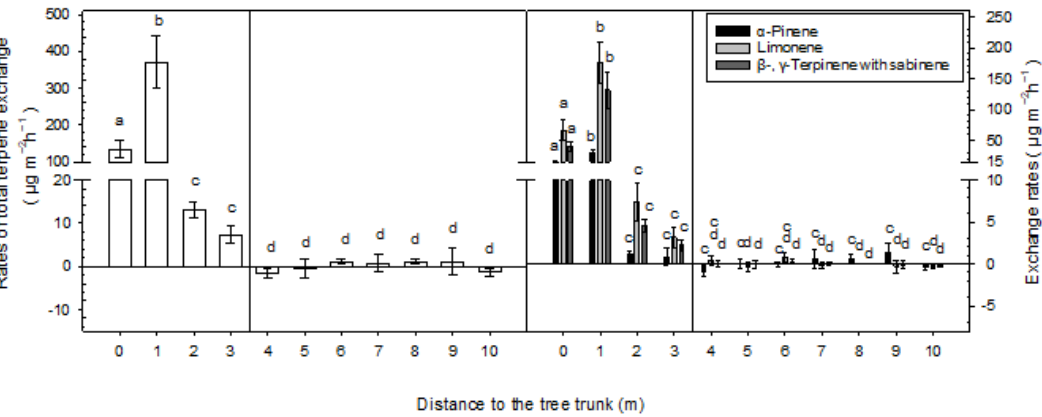
Figure 1. Rates of total terpene, α-pinene, limonene, β- and γ-terpinene with sabinene exchange along the transects. Data are means ± SE; n = 4. Different letters indicate differences among distances ( P < 0.05).